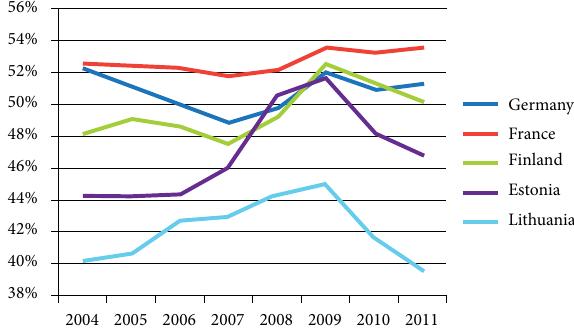
Fig. 3. Part of GDP consisting of compensations for employees in 2004–2011, % (Source: Statistics of Lithuania, OECD (2012) and authorial